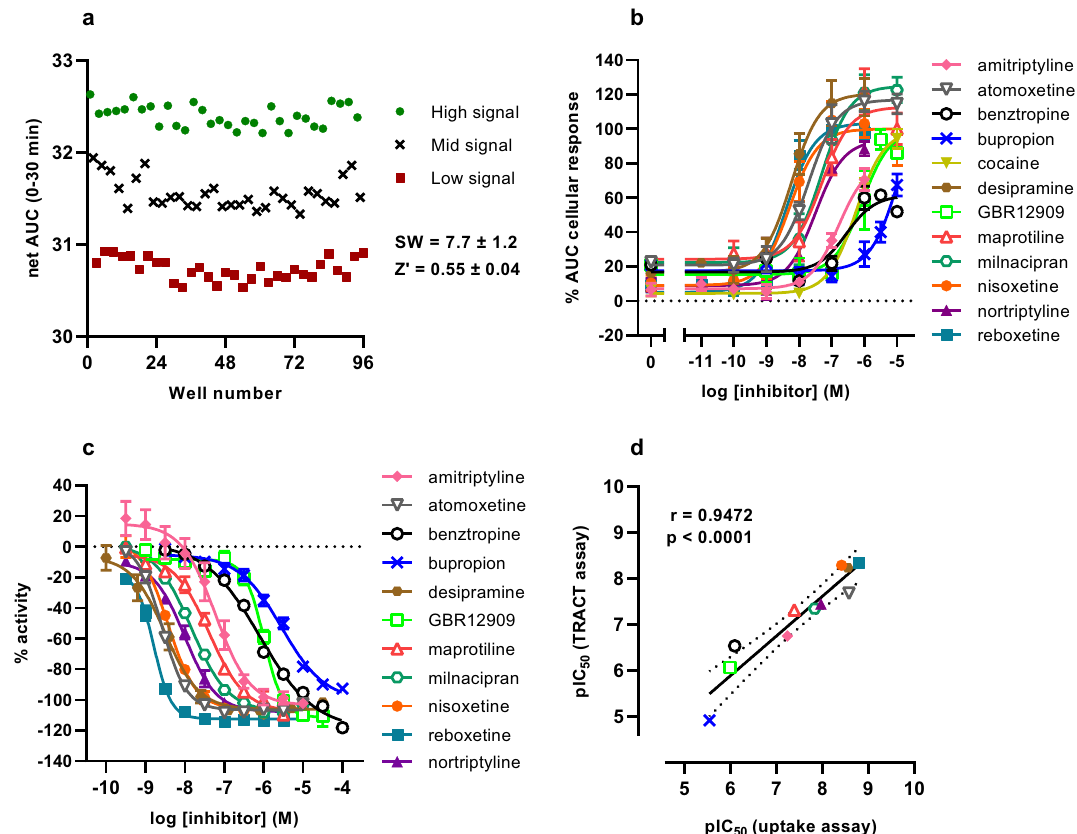
Figure 6. TRACT assay HTS validation and characterization of NET inhibitors in the TRACT assay and the fluorescent substrate uptake assay. ( a ) Validation of the reproducibility and robustness of the TRACT assay. Representative graph of a 96-well E-plate (row-oriented) with wells producing high (1 μM nisoxetine + 1 μM NE), mid (10 nM nisoxetine + 1 μM NE) and low (vehicle + 1 μM NE) cellular responses. Data is presented as the net AUC of the raw nCI traces of the first 30 min after NE stimulation. Each data point in the graph represents a single well. Signal window (SW) and Z ′ factor (Z ′ ) are shown as mean ± S.E.M. and were calculated according to the formulas in TRACT assay HTS validation section. ( b ) Concentration-inhibition curves of NET inhibitors in the TRACT assay. Cells are pretreated for 1 h with vehicle or one of six increasing concentrations of inhibitor, then stimulated with 1 µM NE or vehicle. Data were normalized to the average top and bottom values of the nisoxetine concentration-inhibition curve. Data are shown as mean ± SEM of three to seven individual experiments each performed in duplicate. ( c ) Concentration-inhibition curves of NET inhibitors in the fluorescent substrate uptake assay. Cells were pretreated for 1 h with vehicle or one of ten increasing concentrations of inhibitor, followed by addition of loading dye solution for 1 h. Data were normalized according to the formula in Fluorescent substrate uptake assay section. Data are shown as the mean ± SEM of three to five individual experiments each performed in quadruplicate. ( d ) Correlation plot between pIC 50 values obtained in the TRACT assay and the fluorescent substrate uptake assay. The Pearson’s r coefficient and the corresponding p -value of the linear correlation (solid line) are shown. The dotted line represents the 95% confidence